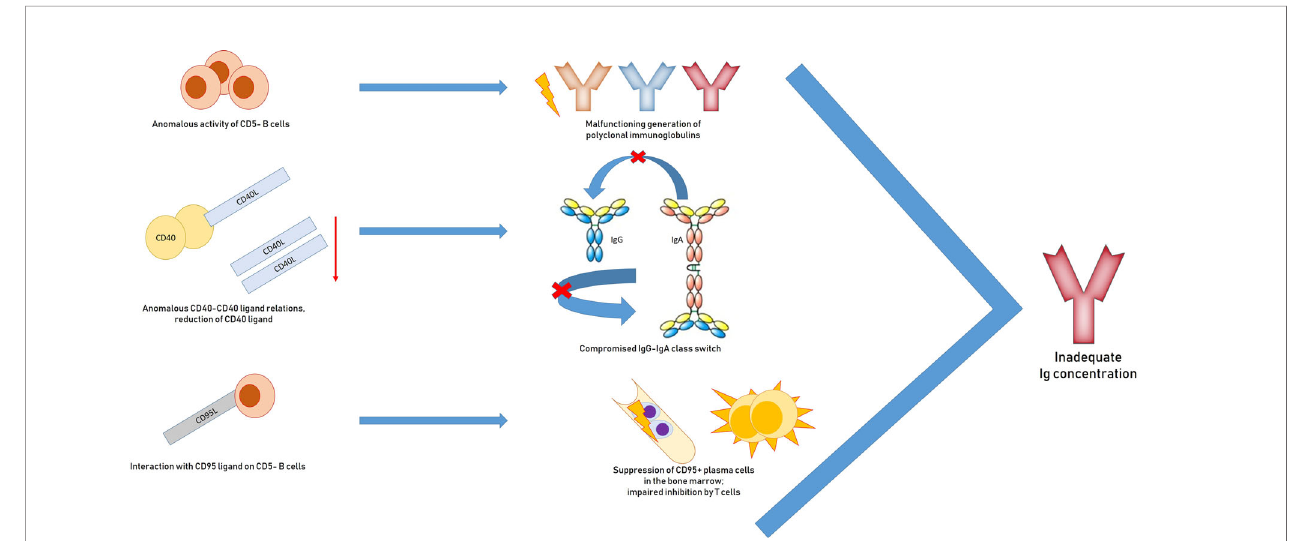
FIGURE 2 | Pathogenesis of hypogammaglobulinemia in patients with chronic lymphocytic leukemia: impaired generation of polyclonal immunoglobulins due to inadequate activation of CD40, suppression of plasma CD95 + cells, impaired inhibition by T